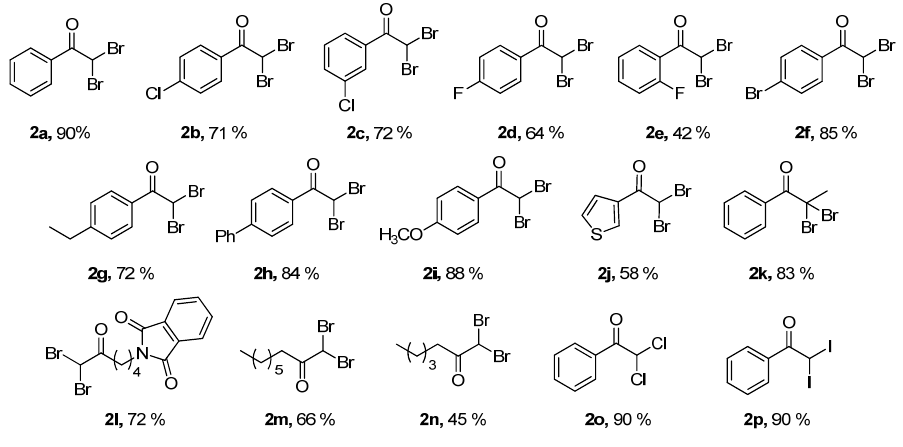
Figure 2. Substrate scope with isolated yields.